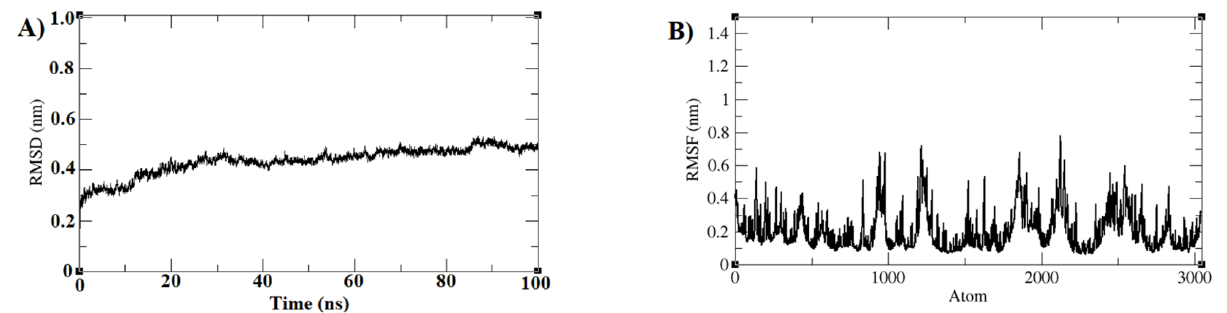
Figure 4. Plots generated from Apo form of AXL kinase 100 ns of MD simulations trajectory ( A ) RMSD and ( B ) RMSF plots. and ( B ) RMSF